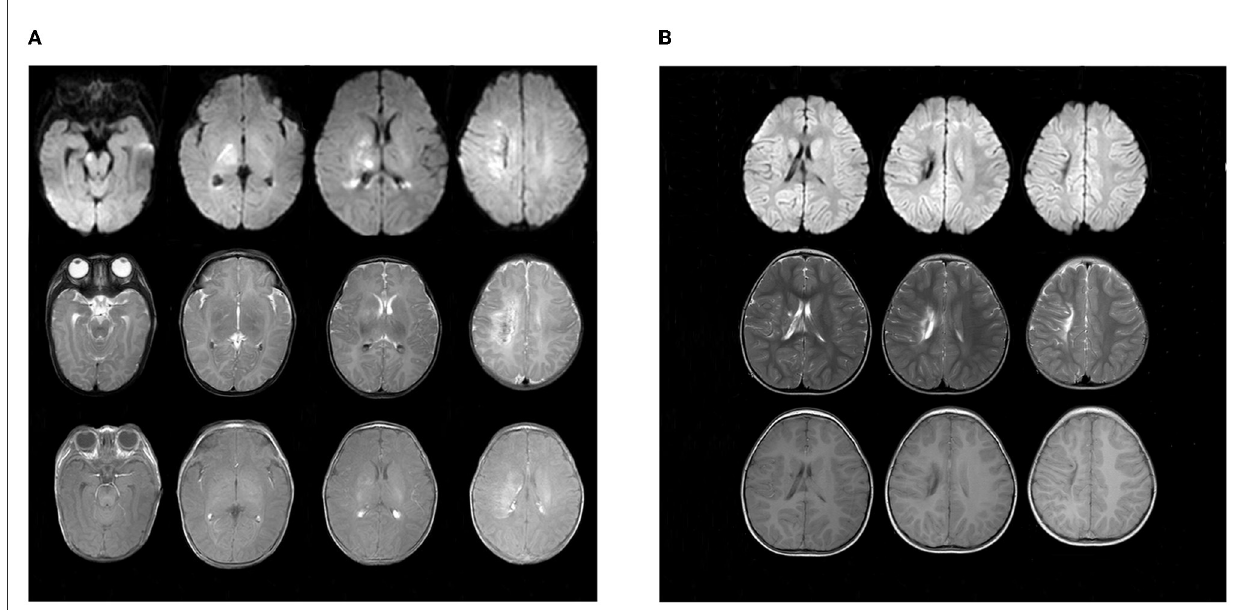
FIGURE4 Findings in sequential MRI brain scans. (A) was taken upon admission in October 2018, showing multiple spots of white matter hyperintensities (in the right central semiovale, lateral ventricle, and basal ganglia) with focal hemorrhage. Patchy, limited diffuse, high signal intensity can be seen in the right central semiovale, lateral ventricle, basal ganglia, and the right side of the brain stem in diffusion-weighted imaging (DWI). (B) Obtained in March 2021, there were still multiple cerebral injuries with enlarged encephalomalacia in the right centrum semiovale, lateral ventricle, and basal ganglia compared with those seen in the previous